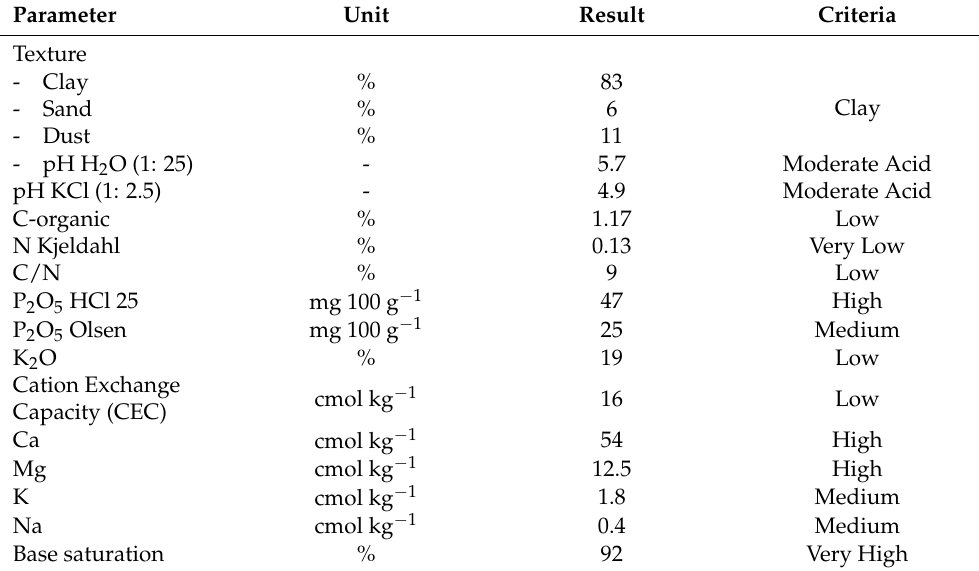
Table 2. Soil properties before the trial, Trenggono, Sidorejo Village, Ponjong District, Gunungkidul Regency, Yogyakarta Province, Indonesia, WS